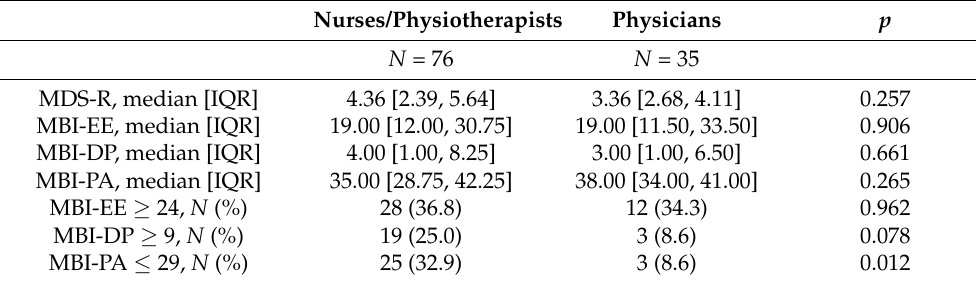
Table 2. Moral Distress and MBI scale scores for nurses/physiotherapists and physicians.